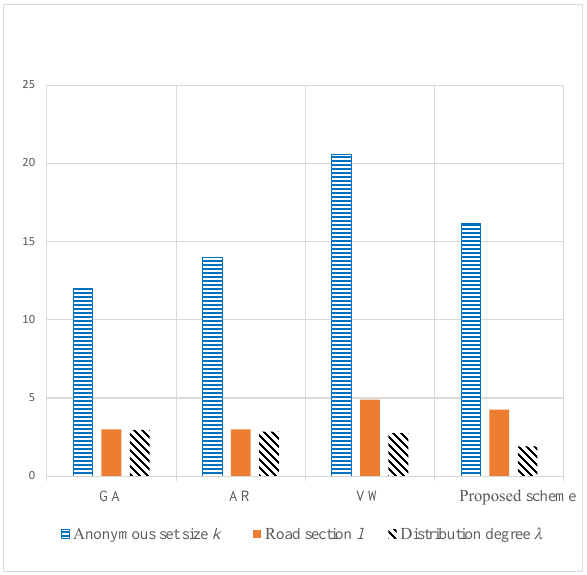
Figure 6. Anonymous set parameters. ( k 0 = 10, l 0 = 3, λ 0 =